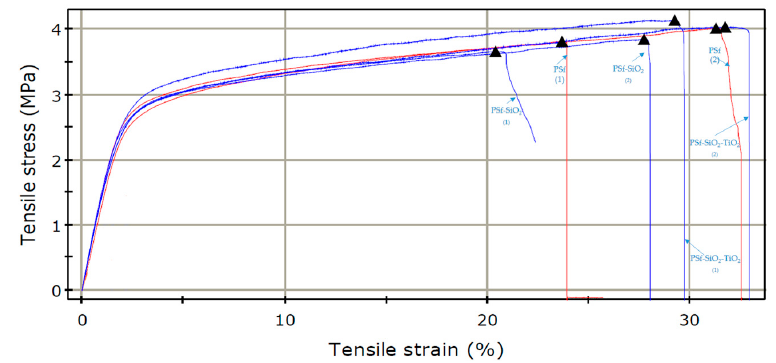
Figure 9. Strain-stress curves for polysulfone-based membranes.